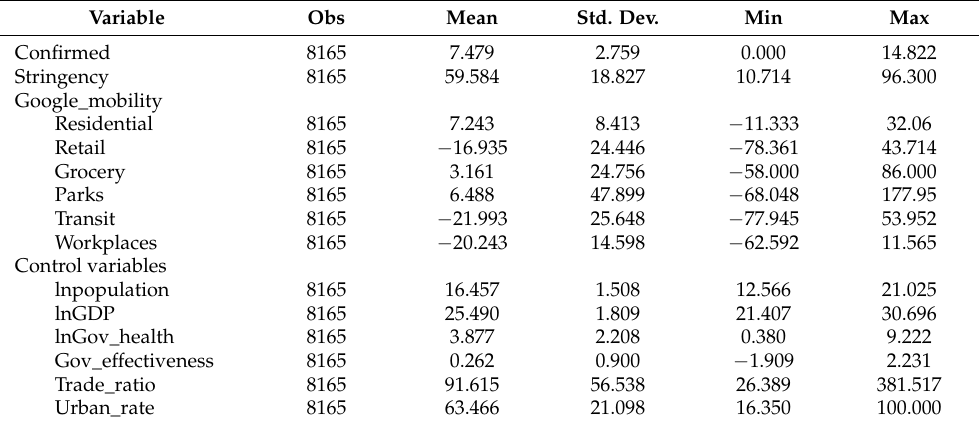
Table 1. Descriptive